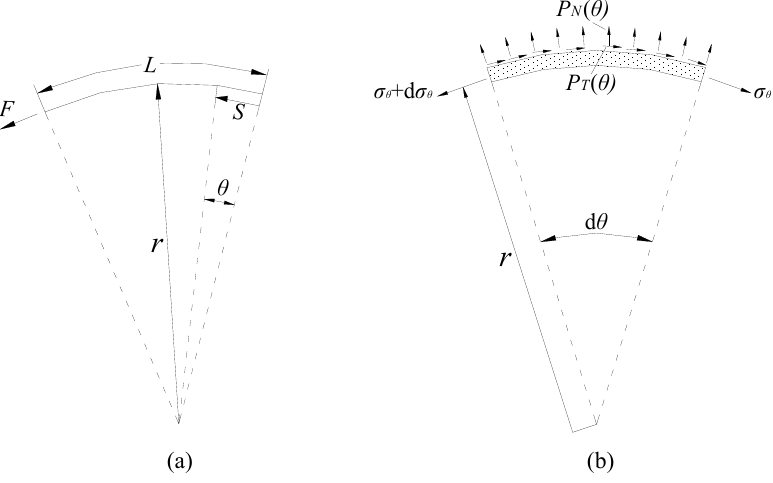
Figure 2. Analytical model: ( a ) curved reinforced interface dimensions; ( b ) infinitesimal section.